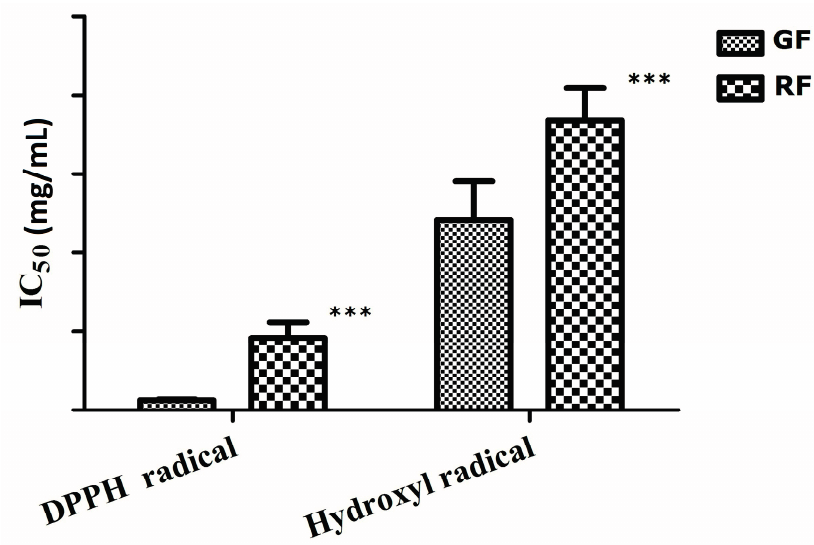
Figure 3. Comparison of antioxidant capacities measured by DPPH and hydroxyl radical scavenging assay between GF and RF. Results are based on independent-sample t -test and presented as the mean ± SD ( n = 10). *** The RF group compared with the GF group, p < 0.001.